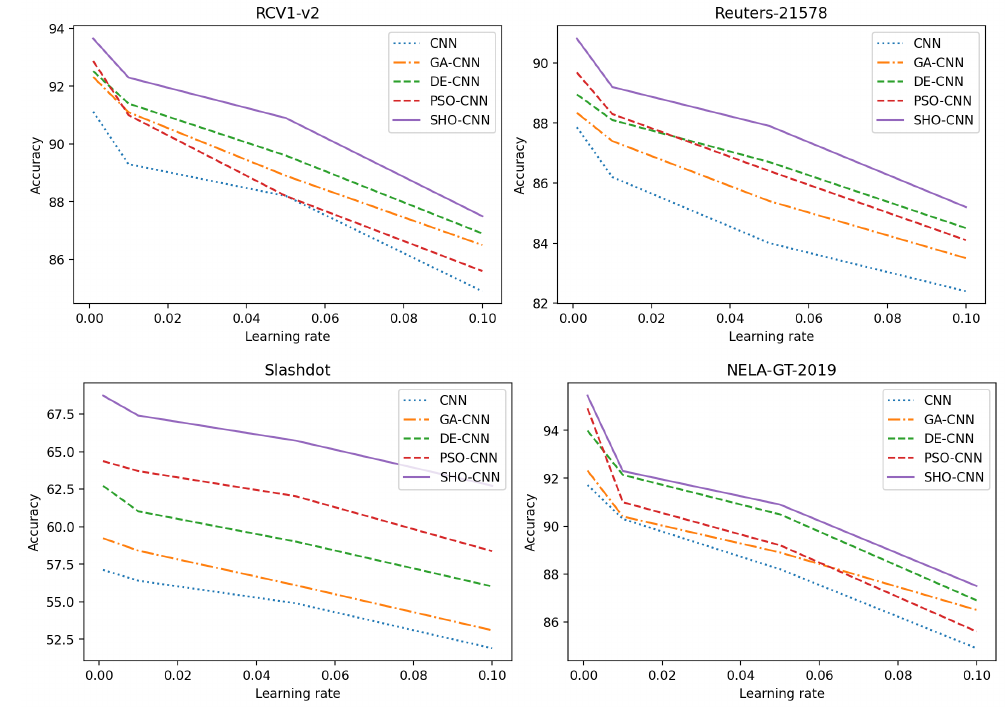
Figure 8. Evaluations based on learning